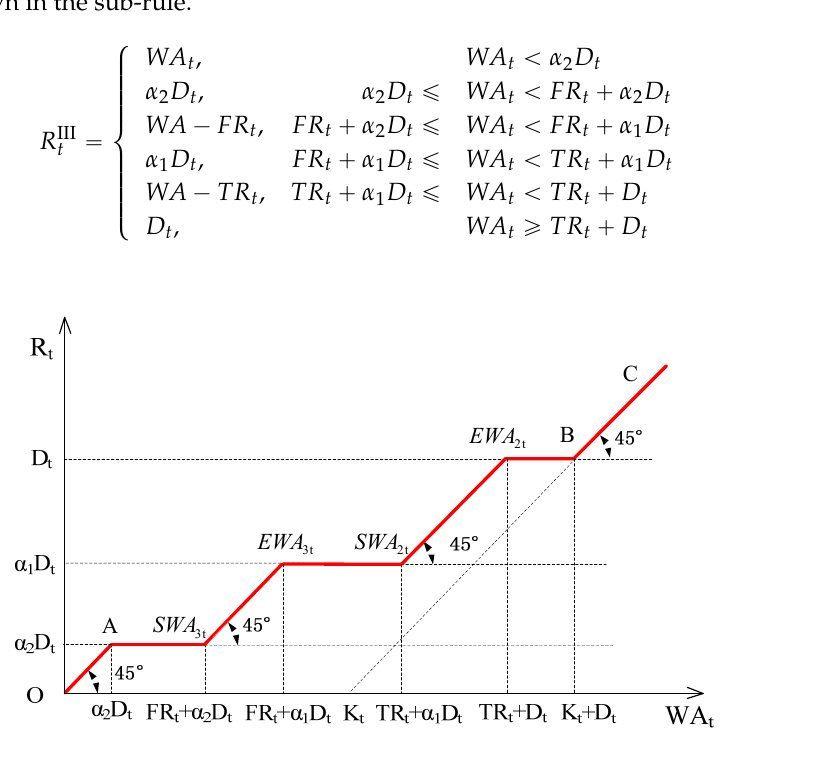
Figure 5. The derived optimal policy for Rule 3.